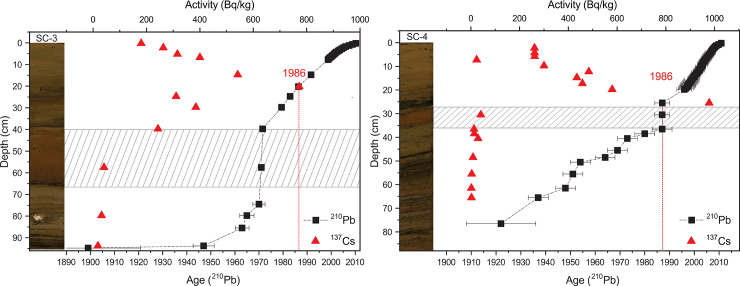
Age-depth model based on 210Pb and 137Cs for SC-3 and SC-4 sediment cores alongside core photos.137Cs and 210Pb concentrations are plotted. Turbidites are marked with diagonal hatching.